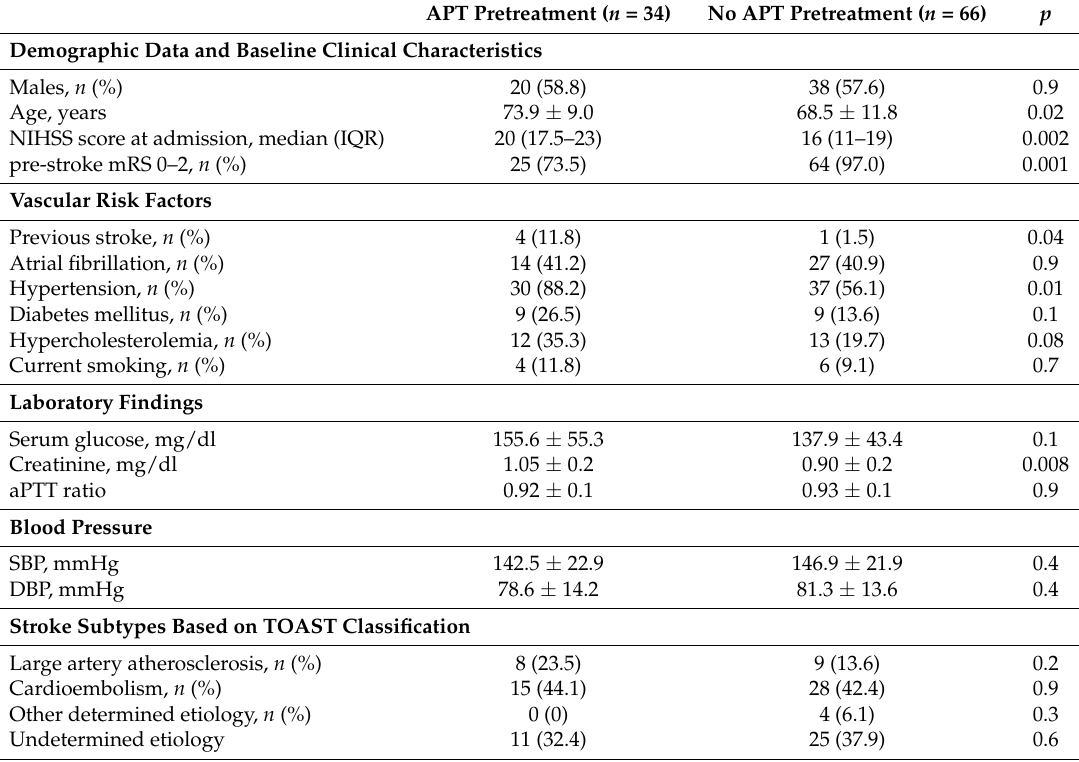
Table 1. Baseline characteristics.